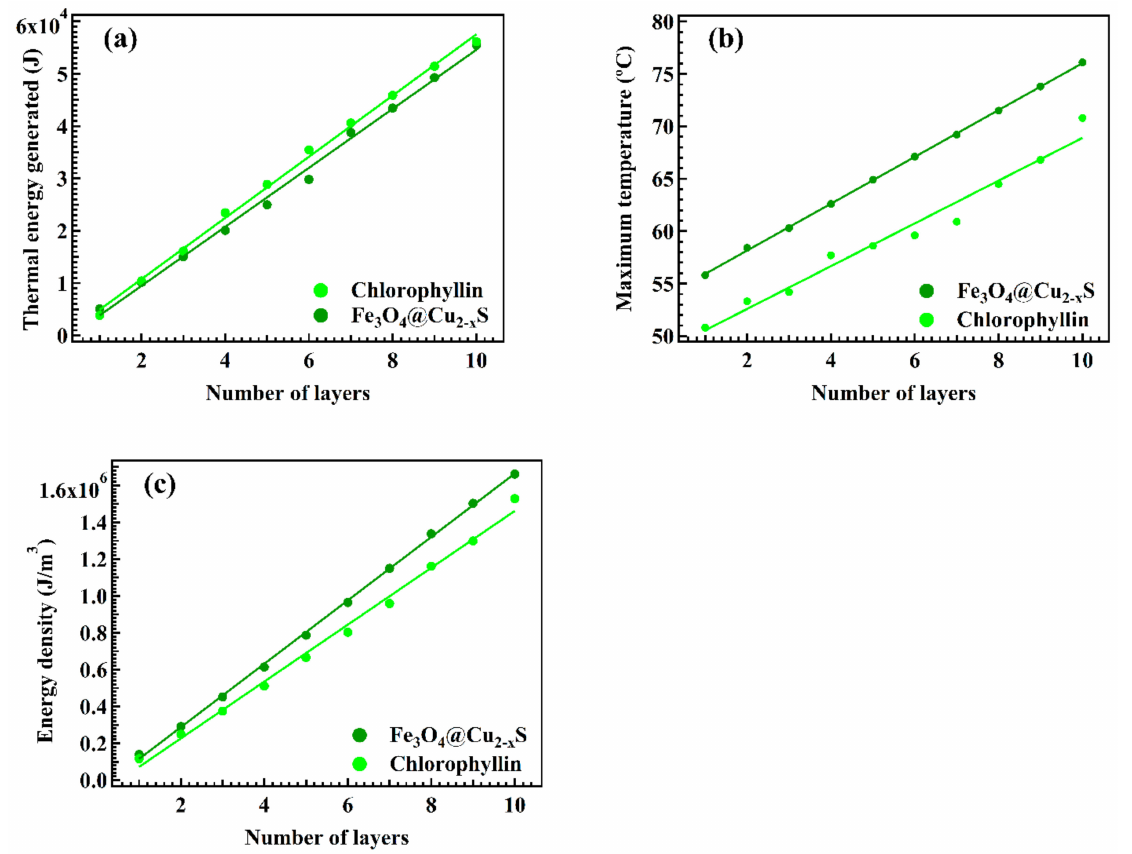
Figure 8. ( a ) Thermal energy vs. number of layers, ( b ) maximum temperature vs. number of layers, ( c ) energy density vs. number of layers for the Fe 3 O 4 @Cu 2 − x S and chlorophyllin thin films for 80 min heating time in the 3D solar photothermal energy generator (Figure 5) [62]. Reprinted with permission from Lyu, Mengyao, Jou Lin, John Krupczak, and Donglu Shi. “Solar harvesting through multilayer spectral selective iron oxide and porphyrin transparent thin films for photothermal energy generation.” Advanced Sustainable Systems 5, no. 6 (2021): 2100006. Copyright 2023 John